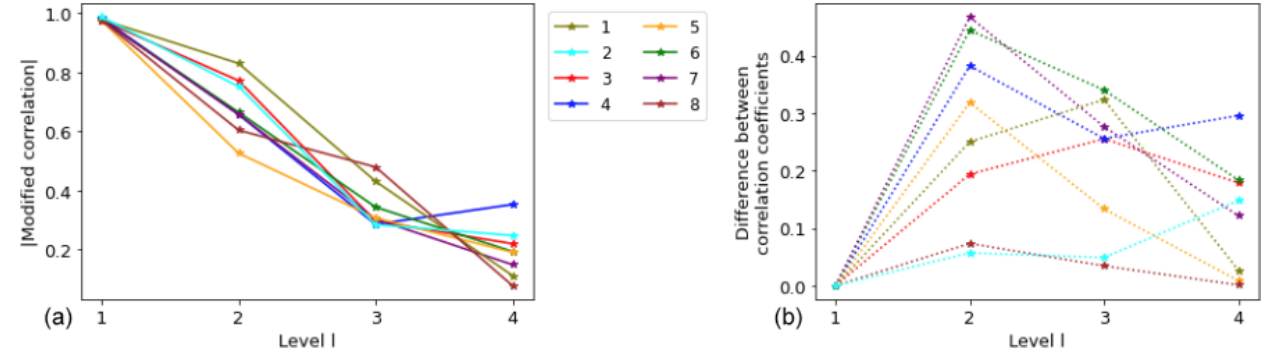
Figure 26. Comparing the real and modified correlation values between SFINCS and XBeach to determine maximum water elevation at eight specific locations in the Myrtle Beach test case. (a) Absolute value of modified correlation (Eq. 9). (b) Difference between absolute value of modified and real correlation.